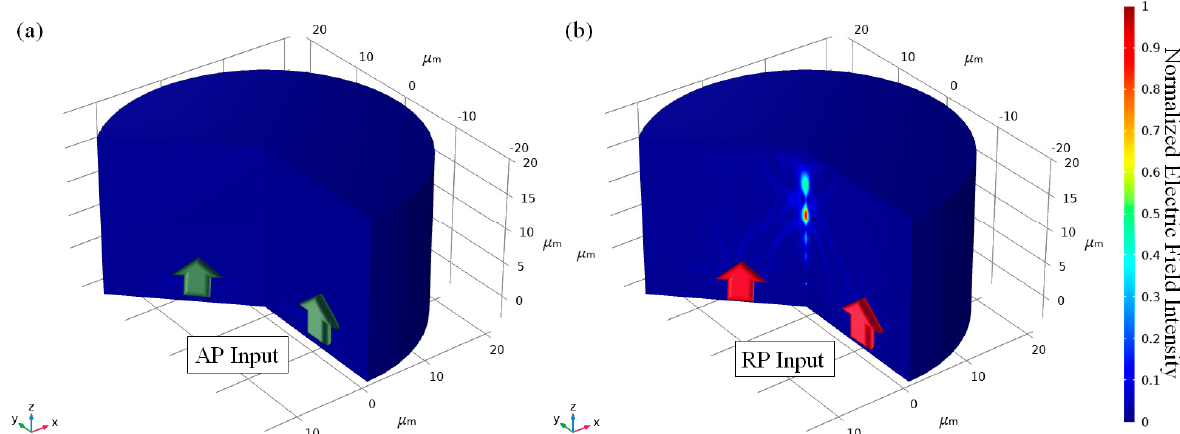
Figure 4. Normalized electric field pattern after protected MSCRA applied dual-focusing lens when the incident light is ( a )